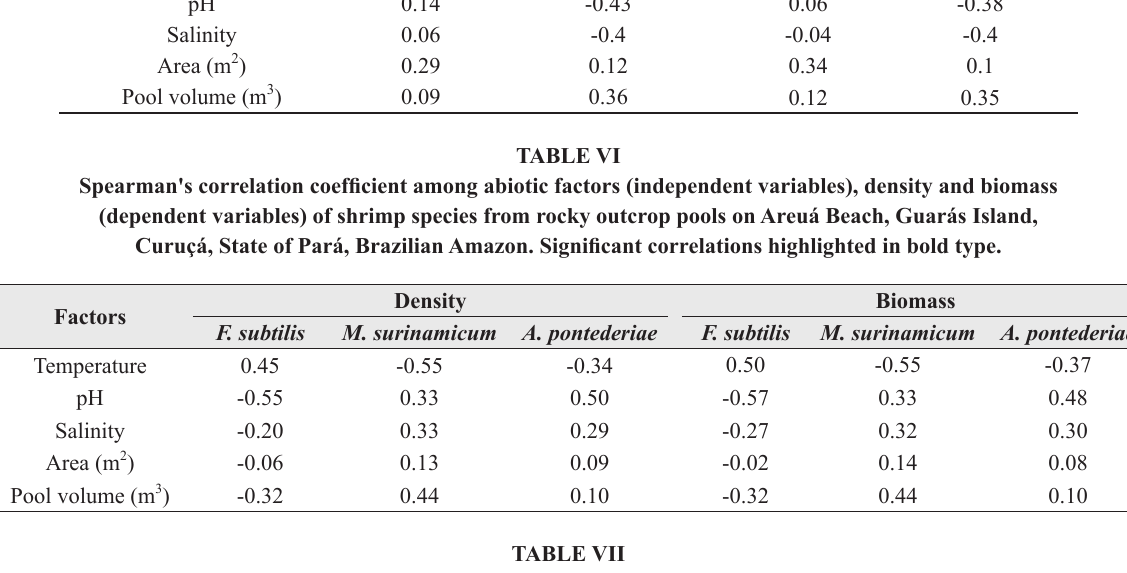
Spearman's correlation coefficient among abiotic factors (independent variables), density and biomass (dependent variables) of shrimp species from salt marsh pools on Areuá Beach, Guarás Island, Curuçá, State of Pará, Brazilian Amazon. Significant correlations highlighted in bold type.